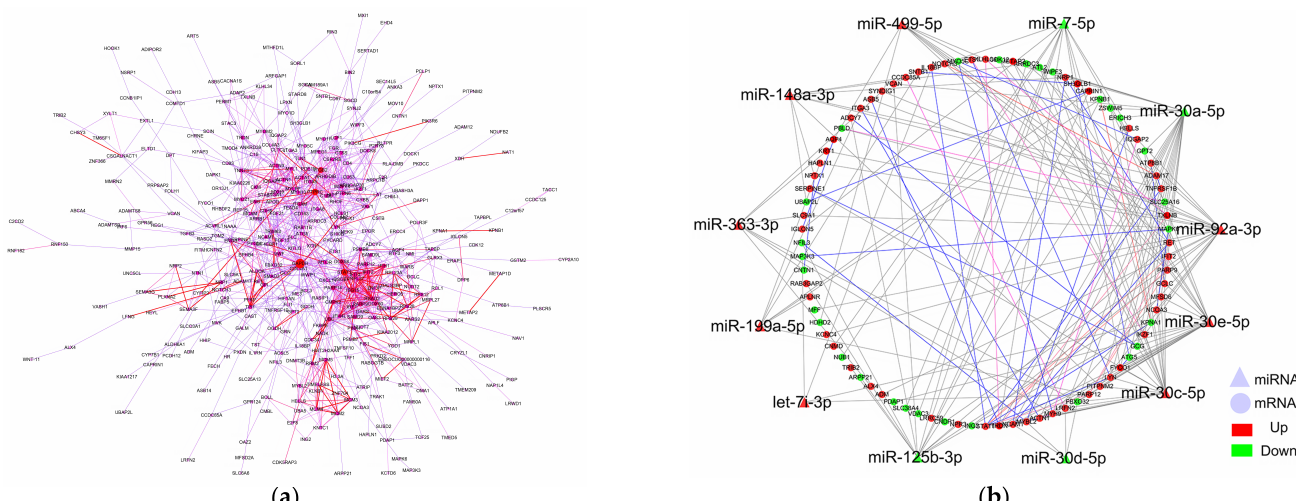
Figure 7. Combined interaction network diagram of DEGs and DEPs and regulatory network diagram of key miRNAs. ( a ) In protein interaction network diagram, circles range in color from blue to purple to red, representing the greater role of genes in the network, and each circle represents a gene. Larger circles represent a greater role of genes. Lines from purple to red show correlations between genes from low to high. ( b ) In miRNA network regulation diagram, triangles represent miRNAs, and red and blue represent upregulation and downregulation, respectively. Color of lines in the network goes from red to blue to indicate that correlation goes from high to low. Table 4. Description of regulatory networks for seven key miRNAs–mRNA pairs involved in rabbit skeletal muscle metabolism.